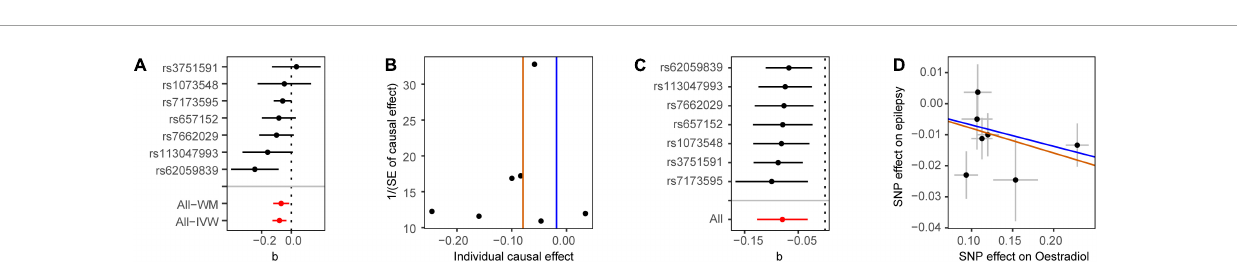
FIGURE3 Mendelian randomization analysis results for estradiol in males on the risk of epilepsy in the replication stage. (A) Forest plot of the causal effect of estradiol in males on epilepsy. (B) Funnel plot showing the estimation using the inverse of the standard error of the causal estimate with each individual SNP as a tool. The vertical line represents the estimated causal effect. SNP, single nucleotide polymorphism. (C) Forest plot of the results of the leave-one-out sensitivity analysis, where each SNP was iteratively removed from the instrumental variables. (D) Scatter plot of SNP effects on estradiol in males and epilepsy. The 95% CI for the effect size on epilepsy is shown as vertical lines, while the 95% CI for the effect size on estradiol in males is shown as horizontal lines. The slope of fitted lines represents the estimated MR effect per method.